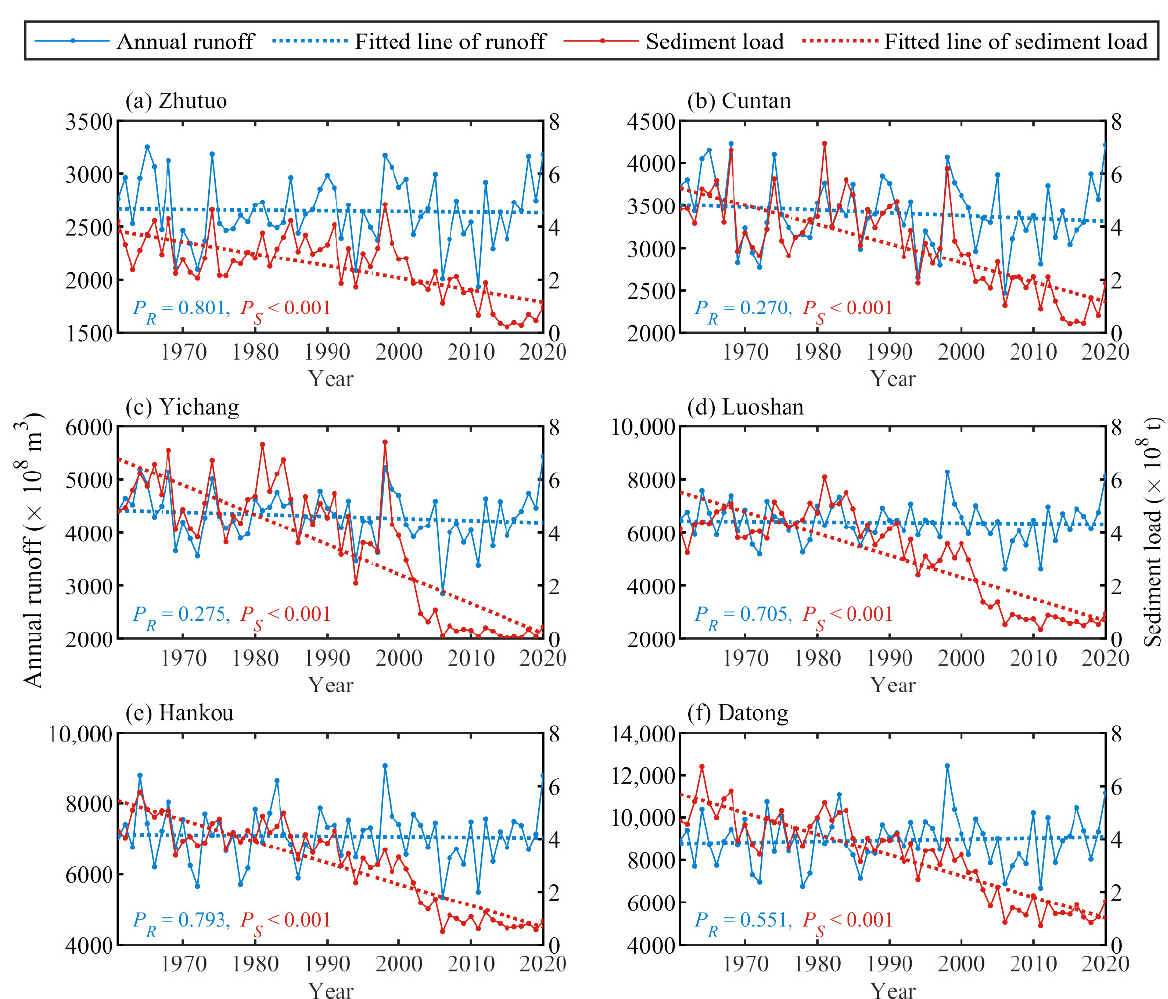
Figure 5. Variation trend of annual runoff and sediment load at six hydrological stations from 1961–